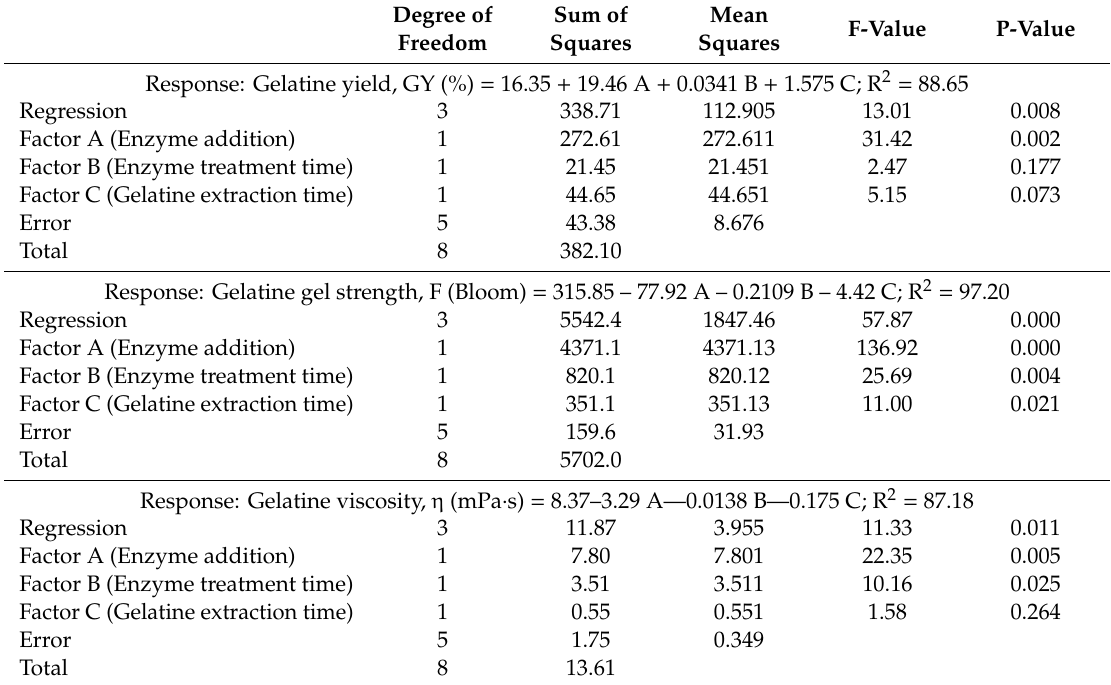
Table 2. Analysis of variance of the experimental design for gelatine yield, gelatine gel strength, and gelatine viscosity (study of the influence of process factors).